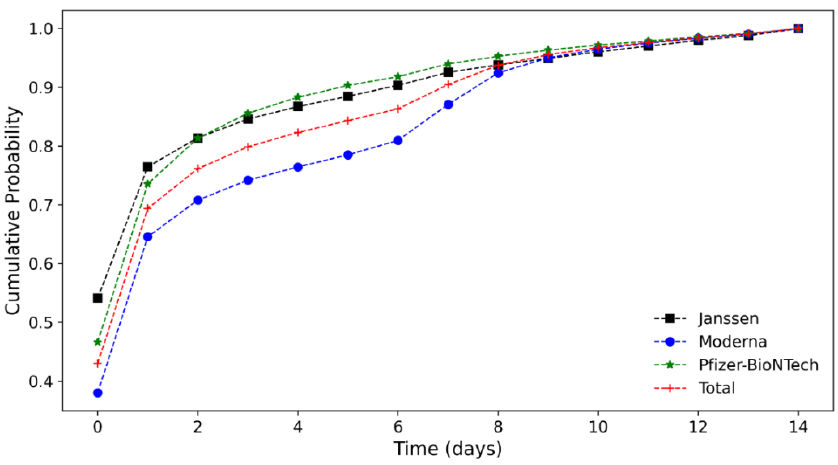
Figure 3. Cumulative probability of AE onset following COVID-19 vaccination.